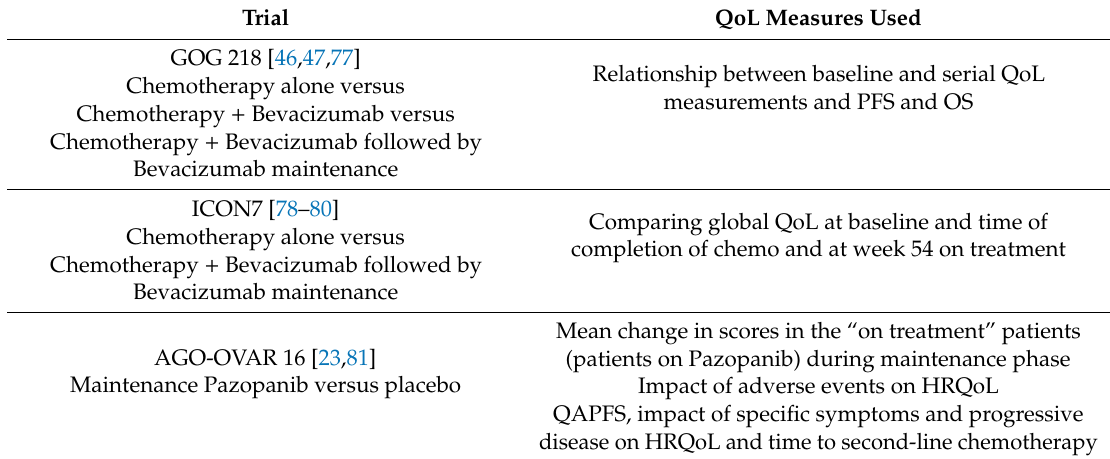
Table 1. Compare and contrast quality of life (QoL) measures in trials involving anti-angiogenics in the first-line treatment of ovarian cancer [23,46,47,77–80].